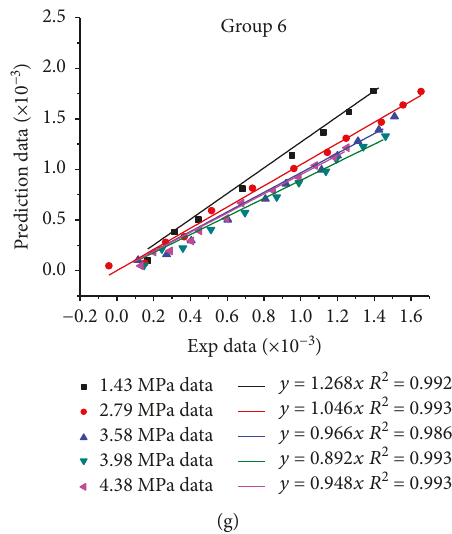
Figure 11: Scattergrams of predictable and experimental value of discharge for conglomerate con fi ned aquifer.